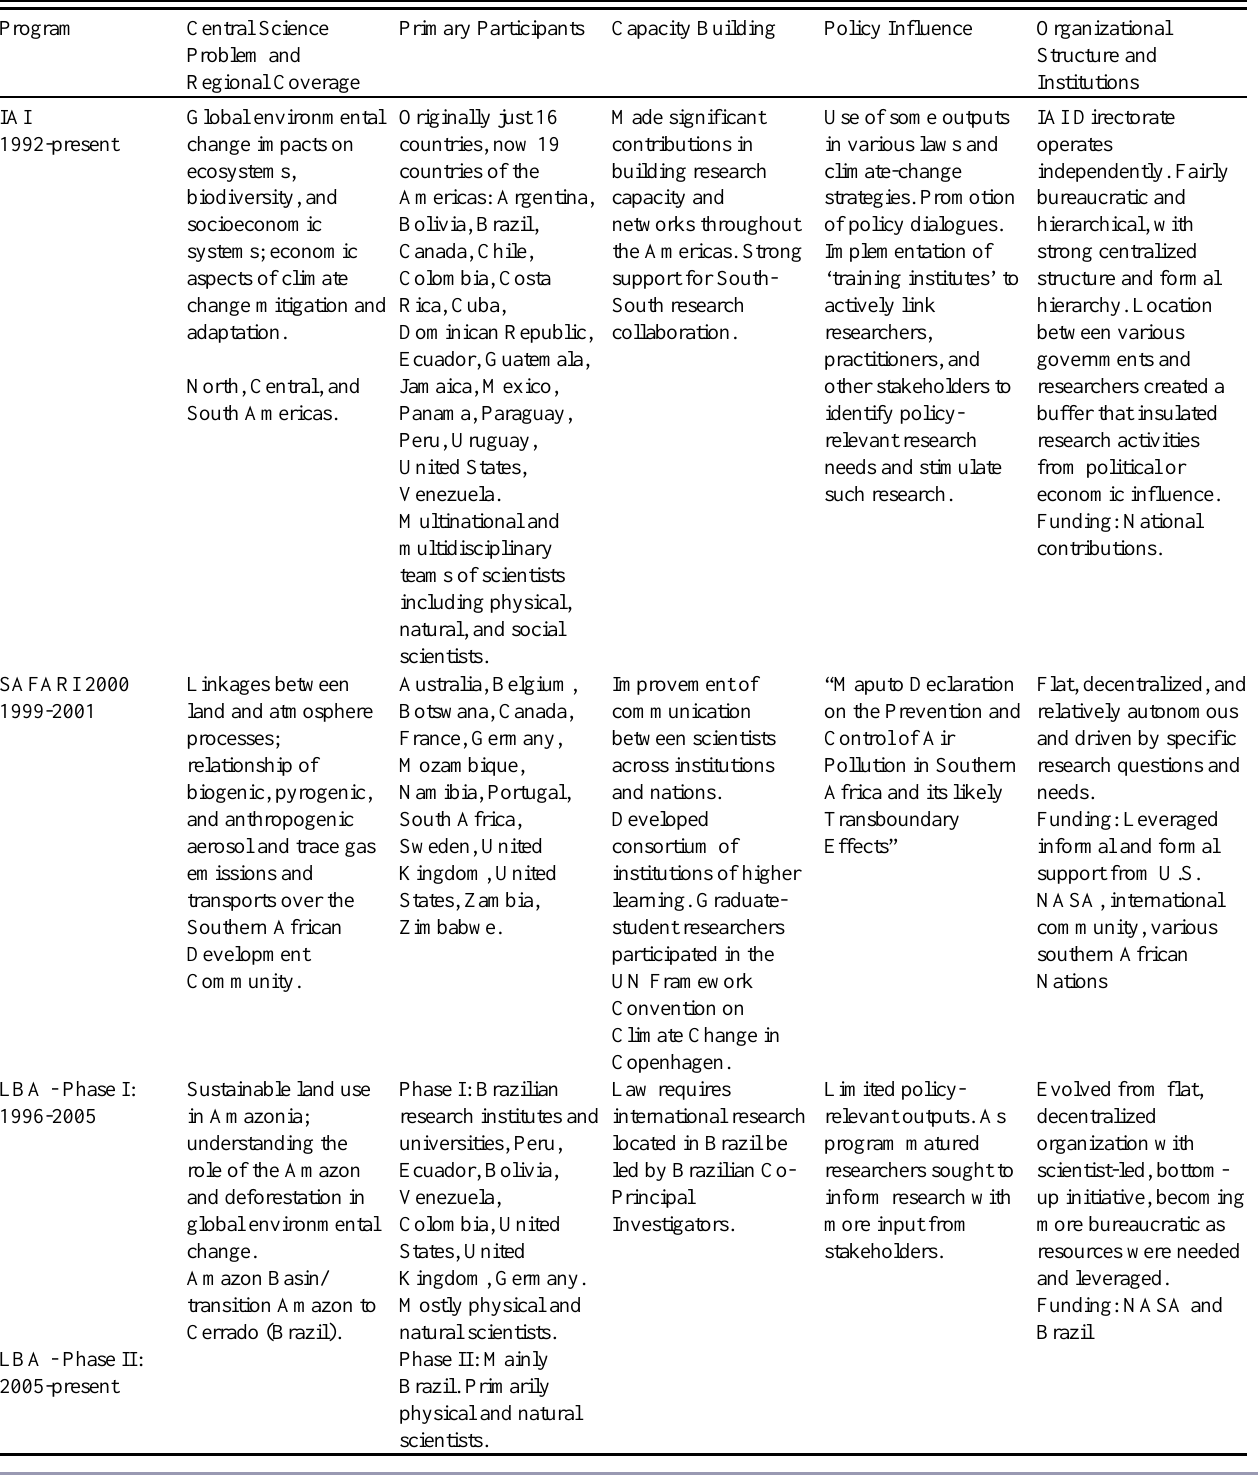
Table 1 . Summary of main characteristics of the three regional networks: Inter-American Institute for Global Change (IAI), Southern Africa Regional Science Initiative 2000 (SAFARI 2000), and Large-Scale Biosphere-Atmosphere Experiment in Amazonia